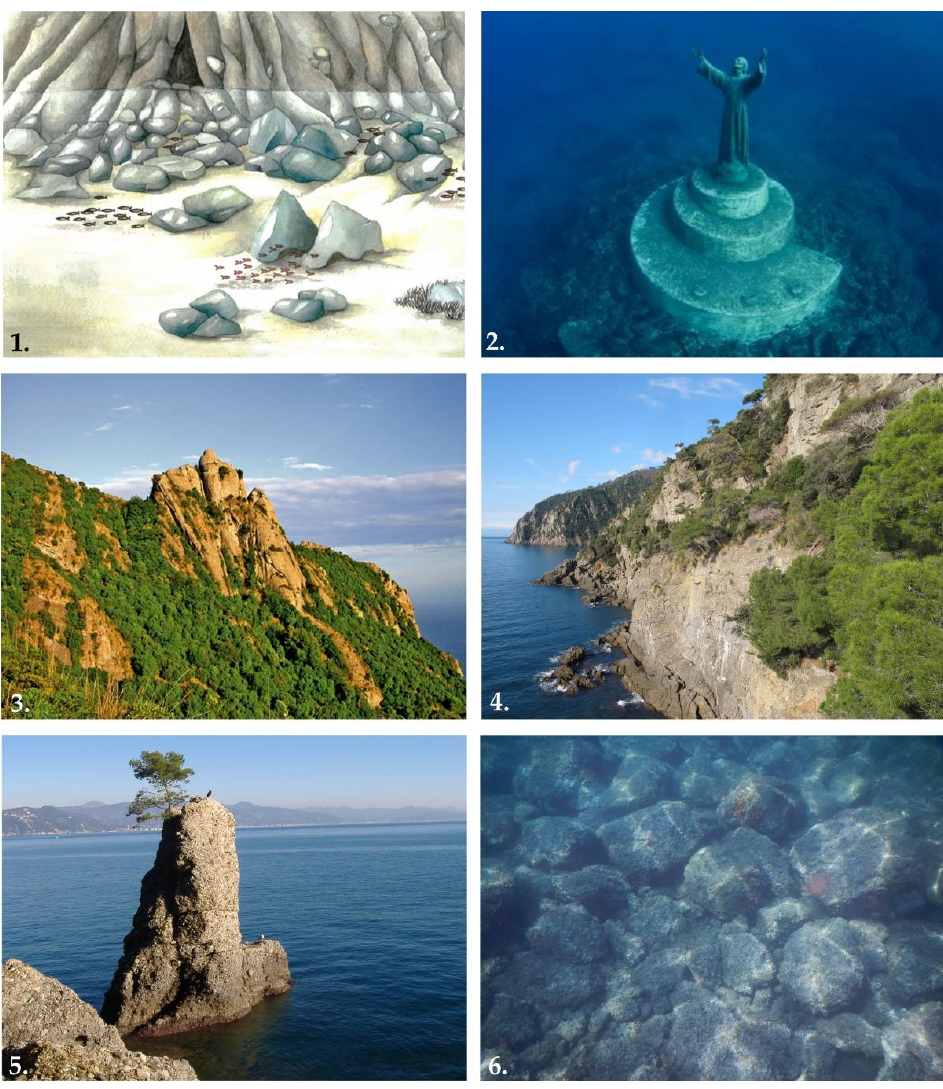
Figure 3. Examples of geosites in the Portofino Natural protected areas: ( 1 ) Grotta dell’Eremita